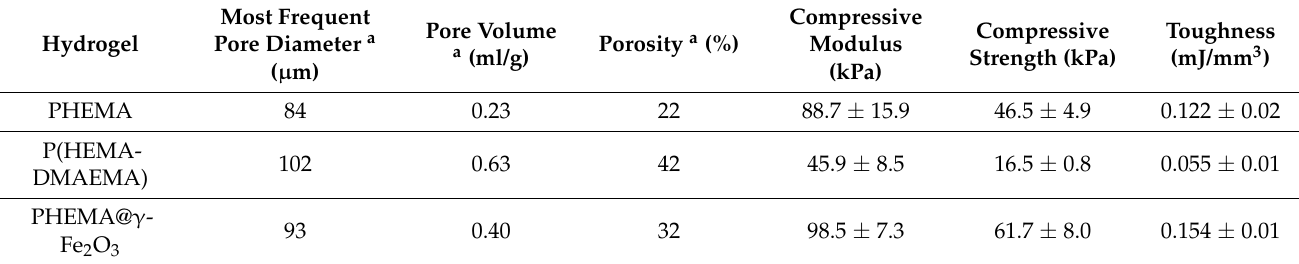
Table 1. Porous and mechanical properties of PHEMA-based hydrogels measured by mercury porosimetry and compression